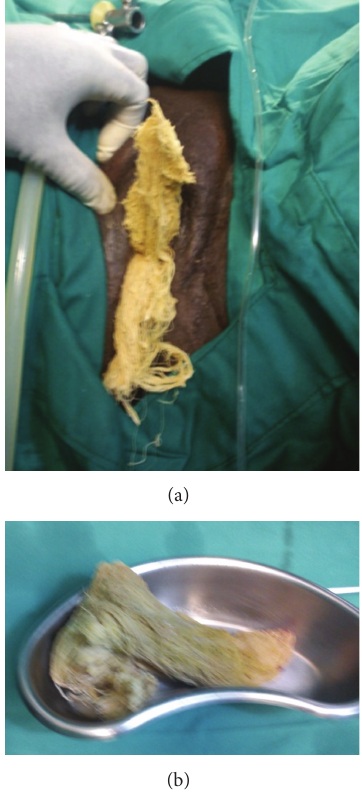
Figure 1: Gauze been pulled out through the urethral meatus and gauze after it was